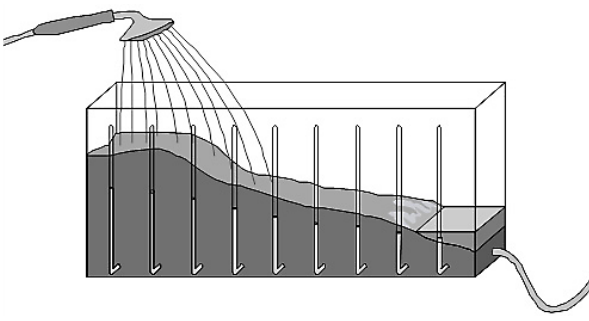
Fig. 3. Demonstration of streamflow generation in a